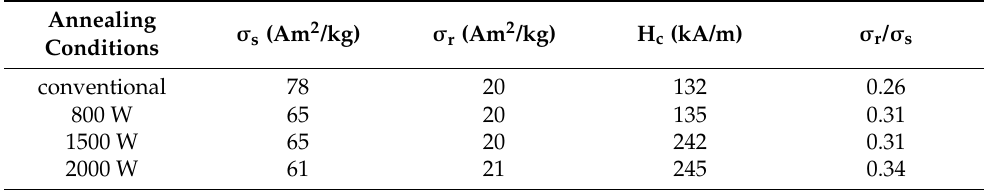
Table 2. The magnetic properties of the annealed (Nd 0.525 Pr 0.175 Ce 0.3 ) 9 Fe 64.5 Co 3 Cu 0.5 Ti 1 B 22 ribbons under different annealing conditions.